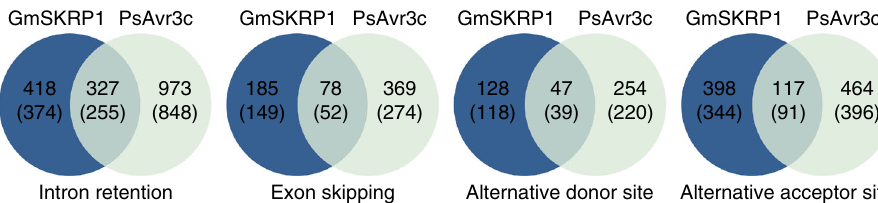
Fig. 6 RNA-seq analyses of soybean hairy roots ectopically expressing GmSKRP1 and PsAvr3c. Venn diagrams indicating the number of overlapping alternative splicing events and corresponding gene numbers that are signi fi cantly alternatively splicing in hairy roots that ectopically express GmSKRP1 or PsAvr3c. The results show that intron retention (327 events) is the most abundant type of event, followed by alternative acceptor site (117 events), exon skipping (78 events), and alternative donor site (47 events). The corresponding gene numbers are shown in parenthesis. Genome coordinates speci fi